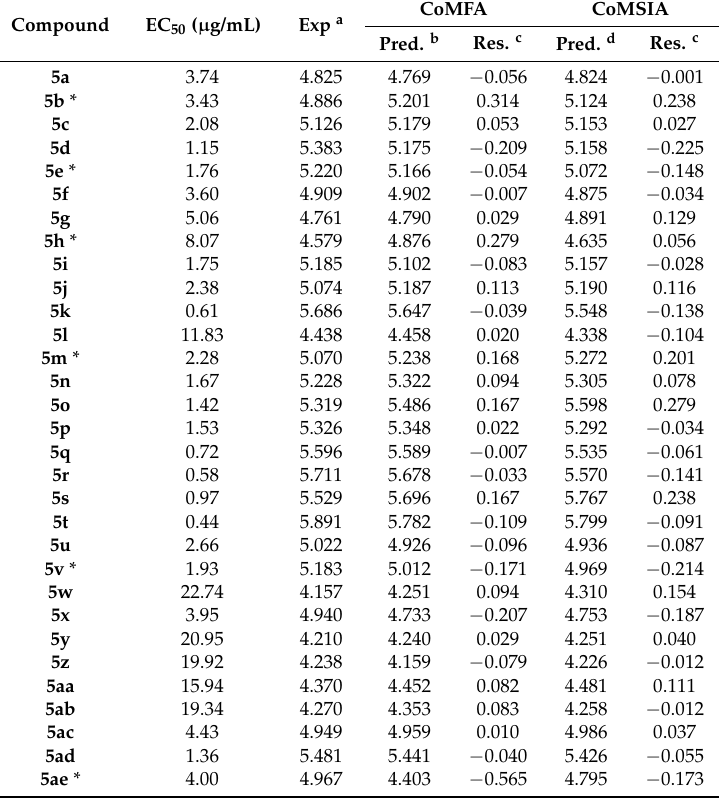
Table 9. Experimental and predicted results of pEC 50 for CoMFA and CoMSIA.